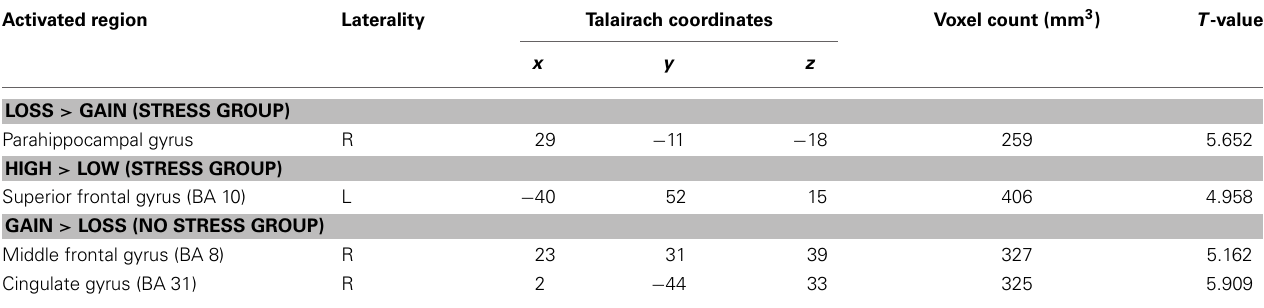
Table 3 | Regions of activation for the contrast between gains and losses and the contrast between high magnitude and low magnitude, in both stress and no stress groups; p < 0 . 005, corrected.